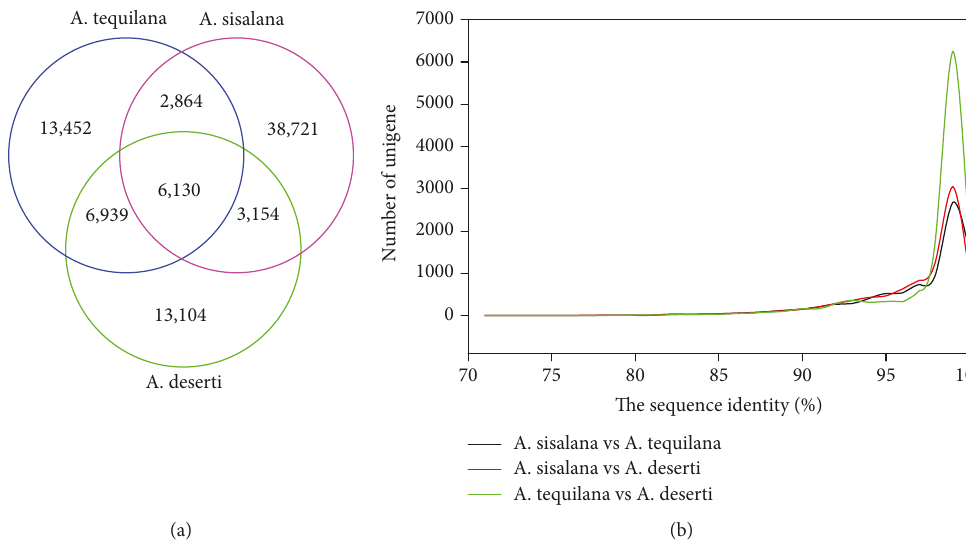
Figure 2: Sequence comparisons between domesticated A. tequilana and A. sisalana and wild A. deserti transcriptomes. (a) The sketch map showing 6130 unigene terms that were identi fi ed within the three transcriptomes. (b) The identity distribution of all orthologous unigene